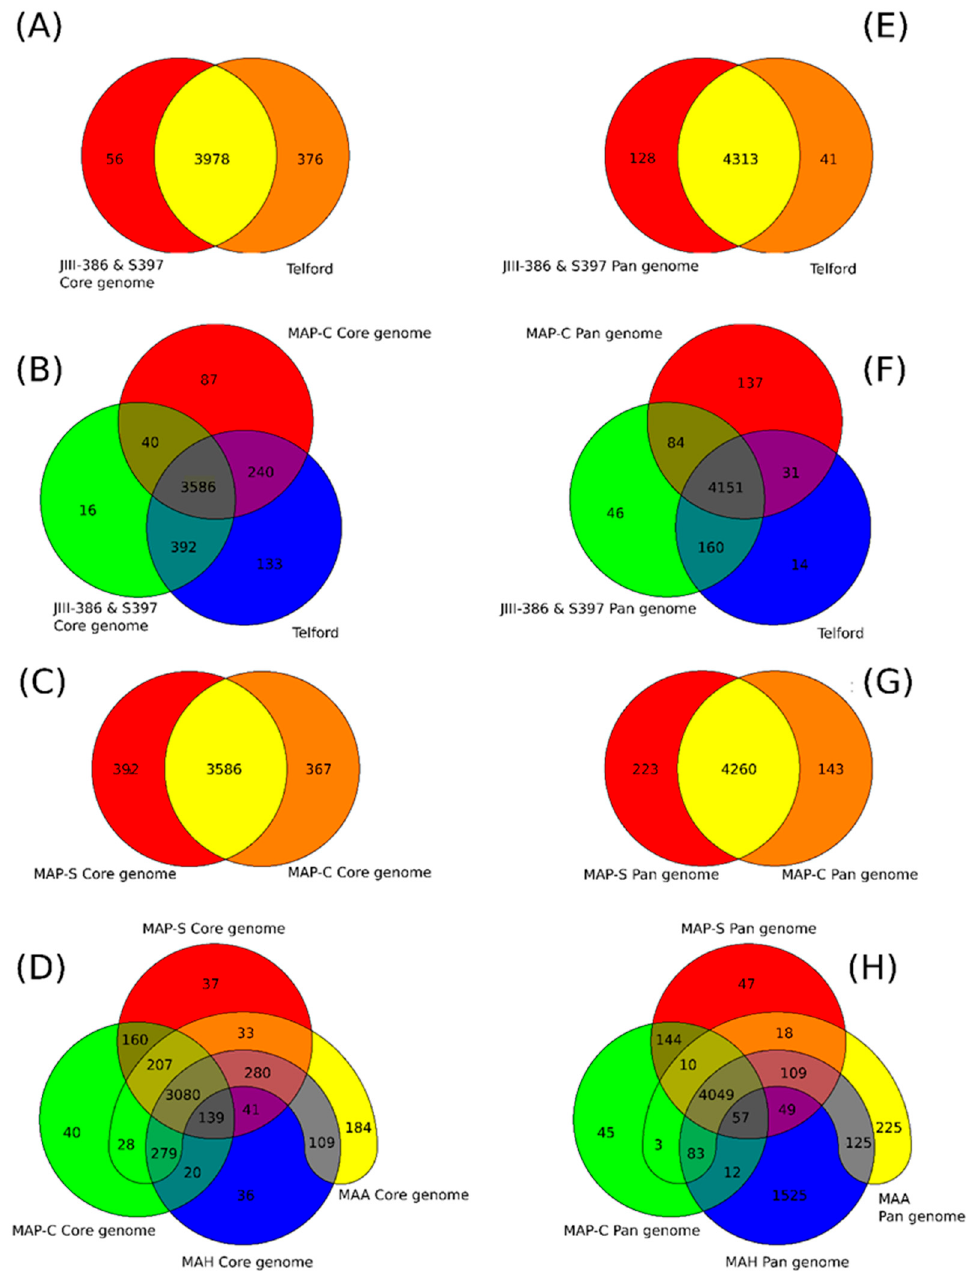
Figure 9. Venn diagrams show results of protein coding gene comparisons of individual genomes and sets of core ( A – D ) and pan ( E – H ) genomes. Diagrams illustrate the number of common genes shared by the specific subsets of genomes shown within the intersections (yellow or mixed) and the number of singleton genes (red, orange, green, blue, and yellow areas). The MAP-S group includes JIII-386, S397, and Telford, and the MAP-C group is comprised of 11 genomes (Table 1, without E93). Genomes belonging to MAH group (n = 5) and MAA group (n = 3) are listed in Table 1. The core and the pan genomes of individual subgroups were calculated with EDGAR software. The pan genome of MAH group was calculated without plasmids.